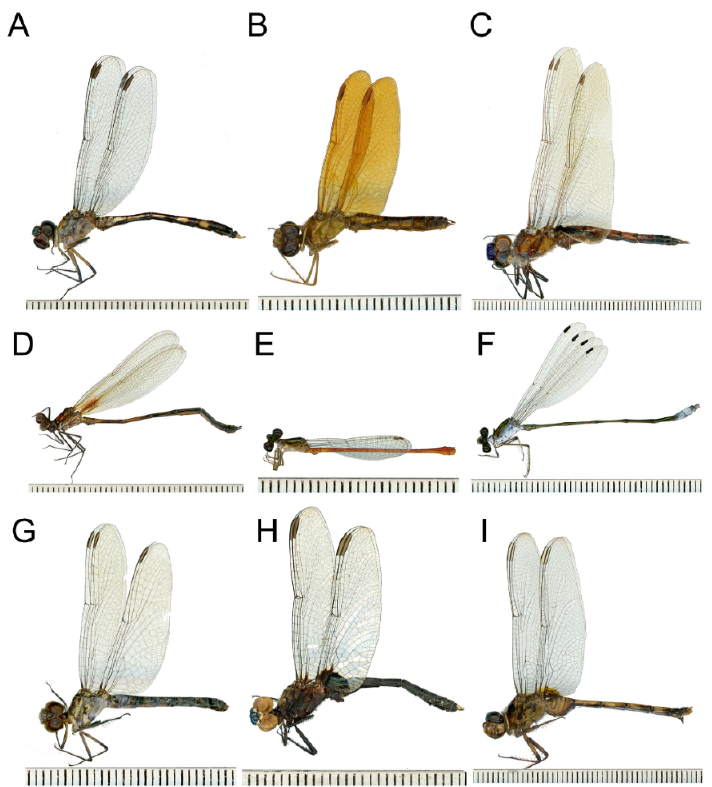
Figure 2. Examples of odonates (Insecta: Odonata) collected and sequenced from Paraíba State, Brazil. ( A ) Anatya januaria , ( B ) Perithemis tenera , ( C ) Tramea cophysa ; ( D ) Hetaerina rosea , ( E ) Telebasis fil ‐